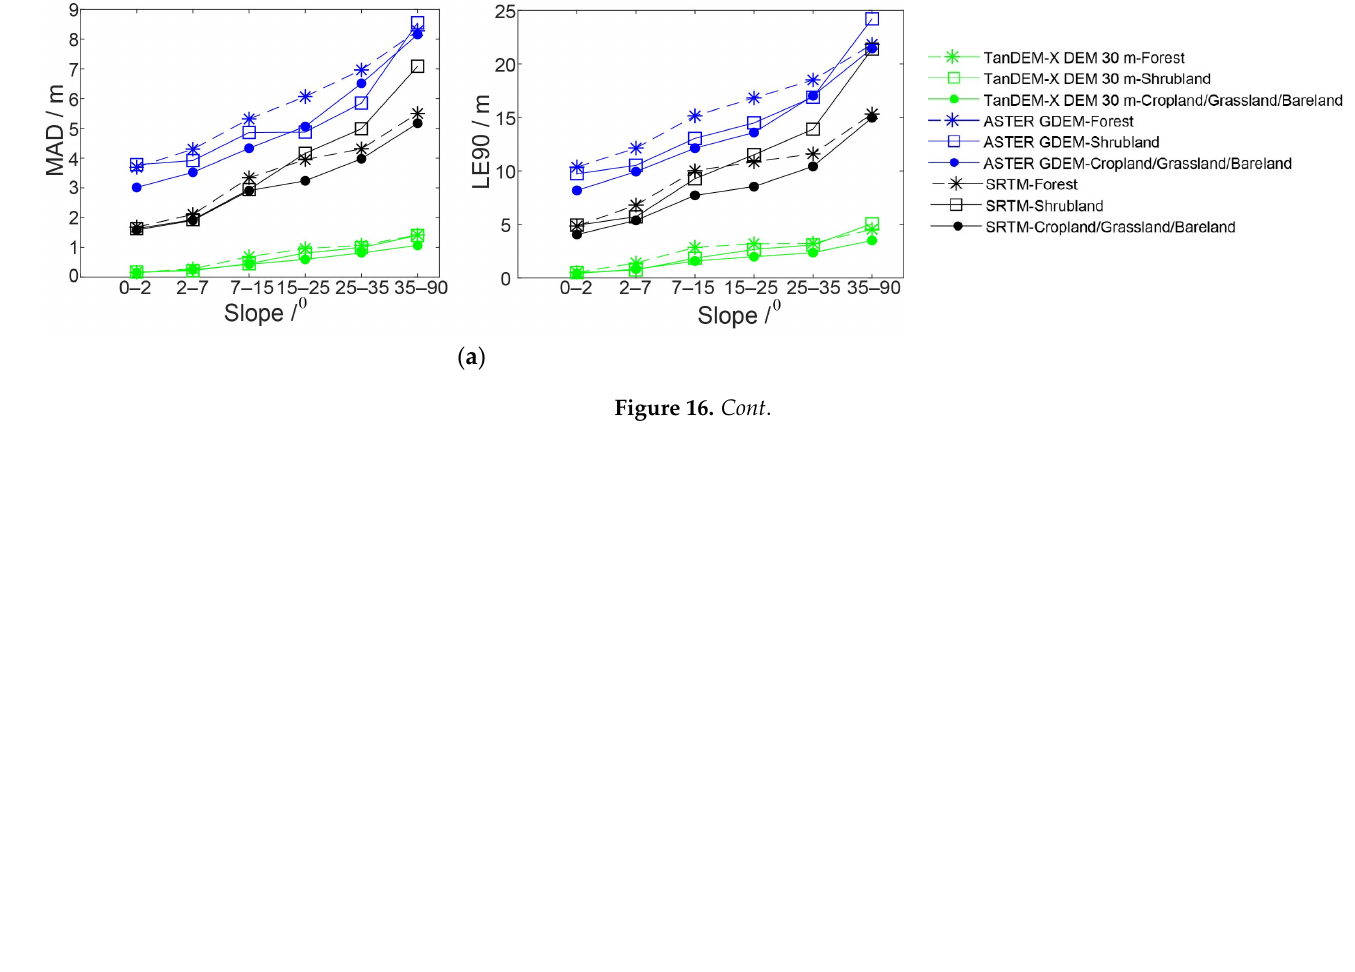
Figure 15. The relationship between quality indicators ((left) MAD and (right) LE90) and aspects in four study areas: ( a ) Sichuan; ( b ) Xinjiang A; ( c ) Xinjiang B; and ( d ) Inner Mongolia.